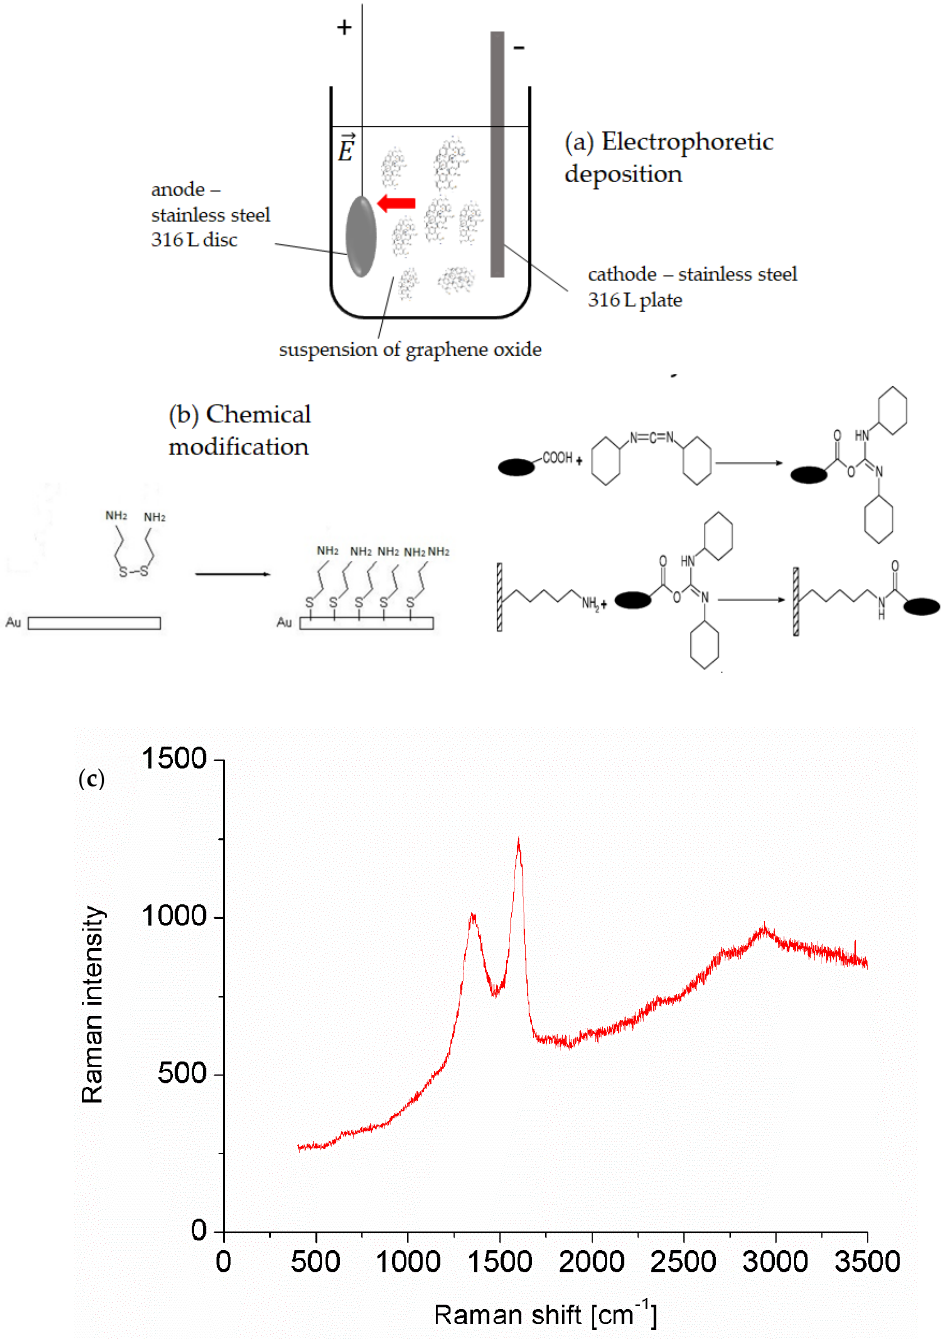
Figure 1. ( a ) Scheme of electrophoretic deposition set, ( b ) scheme of the coating process of gold via the chemical method, and ( c ) Raman spectrum of obtained graphene oxide.